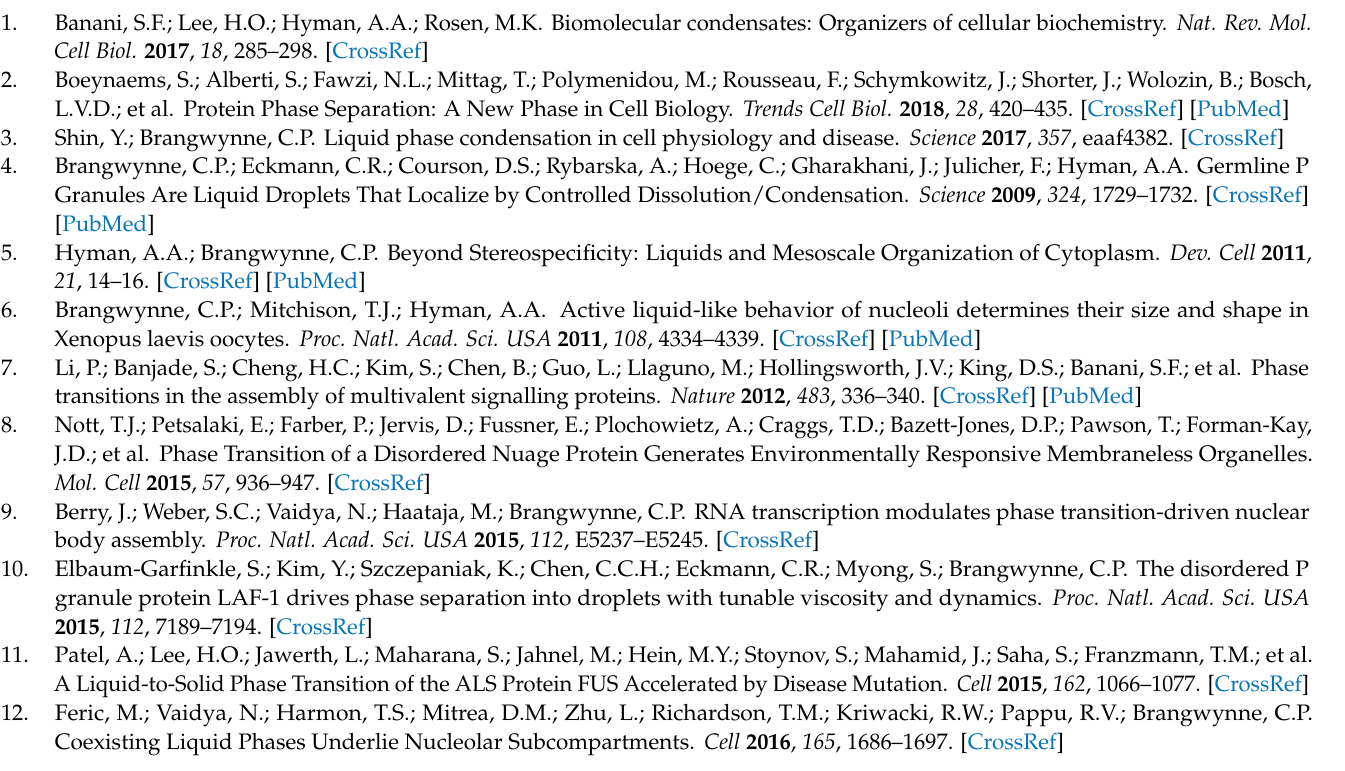
S3: Evolution of phase-separated morphology in the presence of chemical reactions and for φ rib = 0.22 corresponding to Figure 6A. 4. Video S4: Evolution of phase-separated morphology in the absence of chemical reactions and for φ rib = 0.80 corresponding to Figure